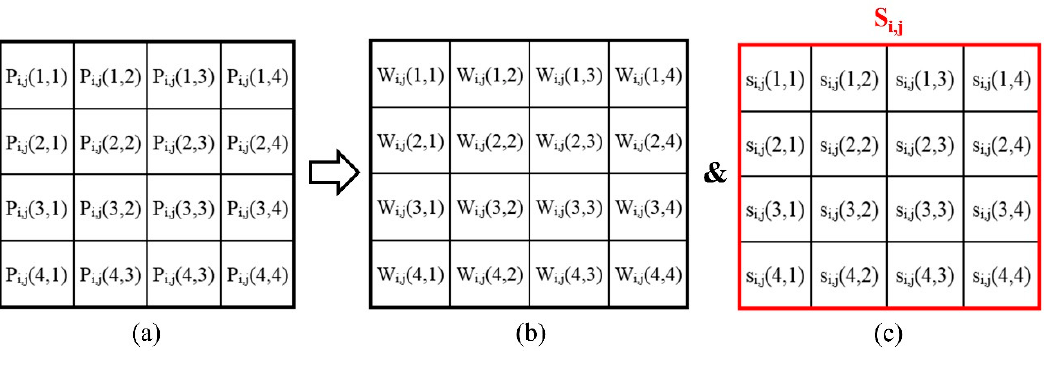
Figure 3. Weight-and-unmixing processing approach: ( a ) represents the reflectance of Planet VNIR; ( b ) represents the weight ensured by ( a ), and; ( c ) represents Sentinel-2 12 m resolution pixels containing 16 pixels of 3 m resolution Sentinel-2.